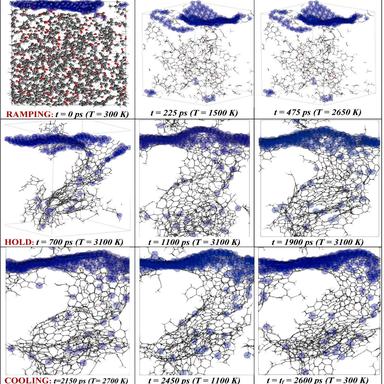
Evolution of GrGC nanostructure with the original Gr molecules shown in blue color. The evolution of the hybrid material in this process happened under three heat regimes: ramping from 300 K – 3100 K (fist row), holding at Tmax = 3100 K (second row), and finally cooling from 3100 K – 300 K (third row). During these regimes, (i) binding of carbon atoms of Gr monolayer to oxygen molecules of epoxy group of SU-8, (ii) breakdown of hydrocarbons, (iii) carbonization of SU-8 monomers at Gr edges, and (iv) formati